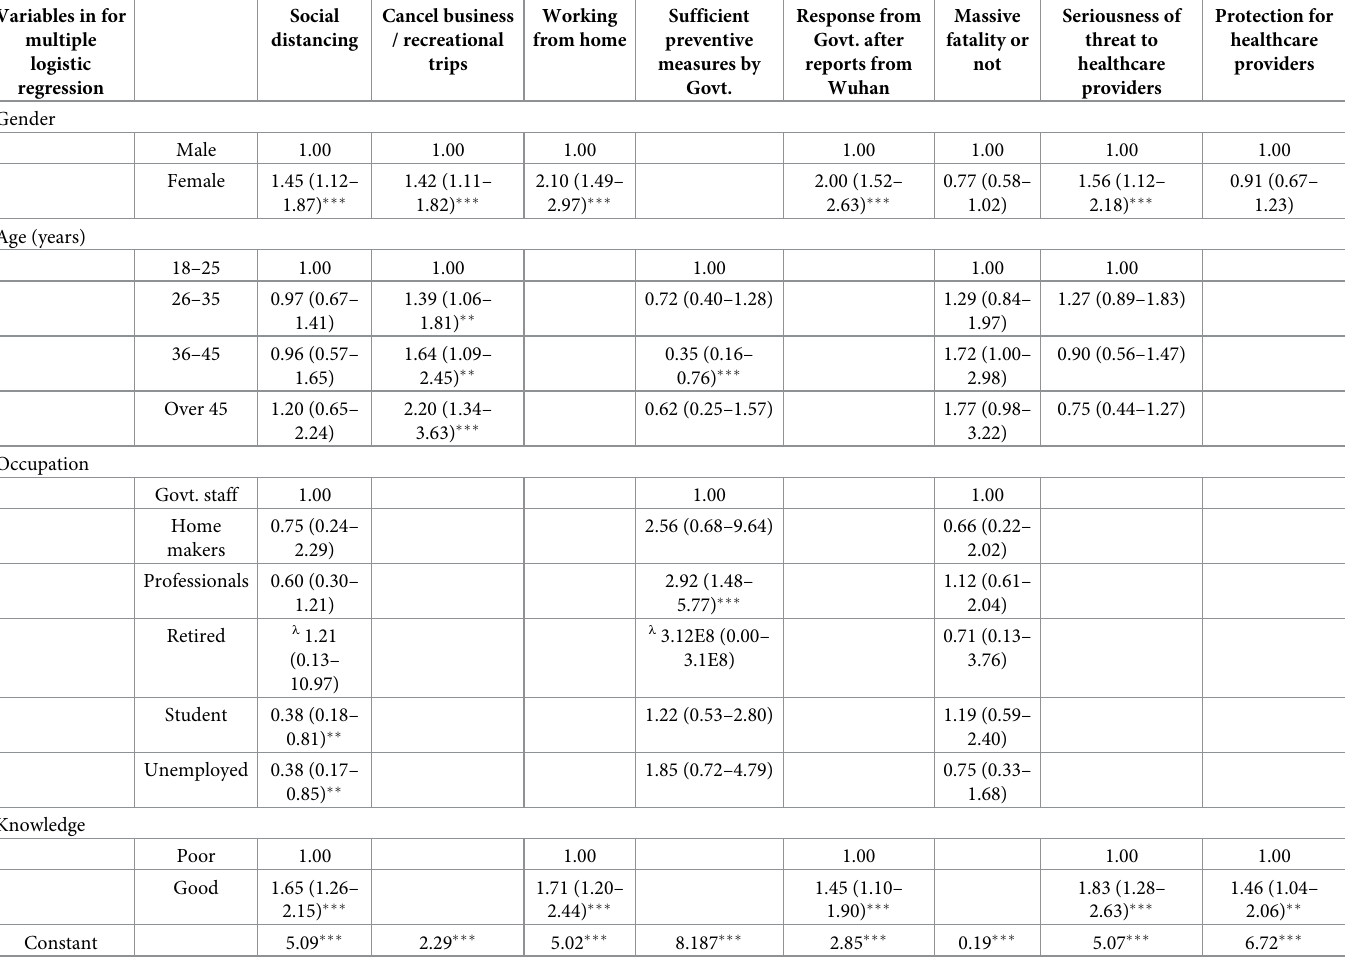
Table 7. Multiple logistic regressions of different variables of attitudes with socio-demographic variable and knowledge status. (Values are odds ratio followed by 95% confidence interval in parenthesis). Variables in for